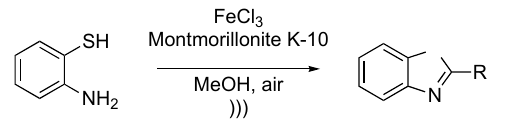
/ Montmorillonite. The Scheme 23. Synthesis of 2-substituted benzothiazoles catalyzed using FeCl 3 /Montmorillonite. 3